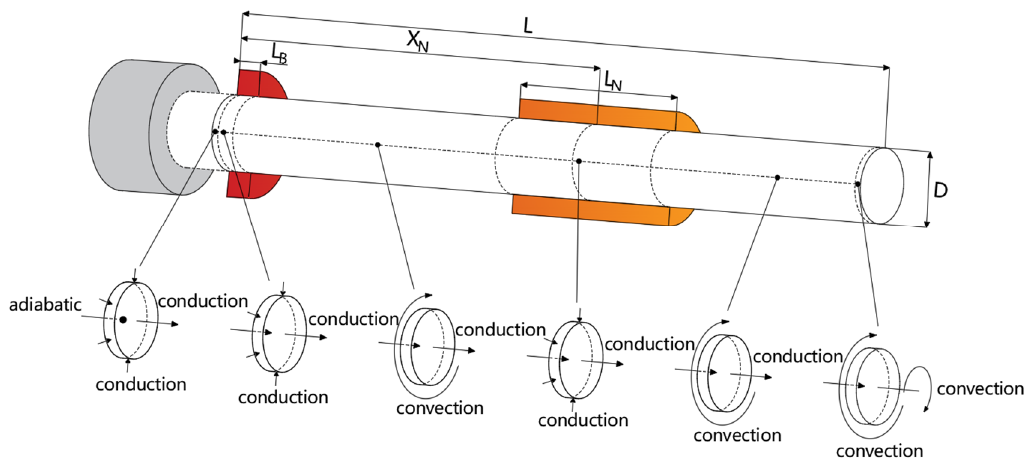
Figure 2. Schematic of thermal analysis of ball screw feed system.